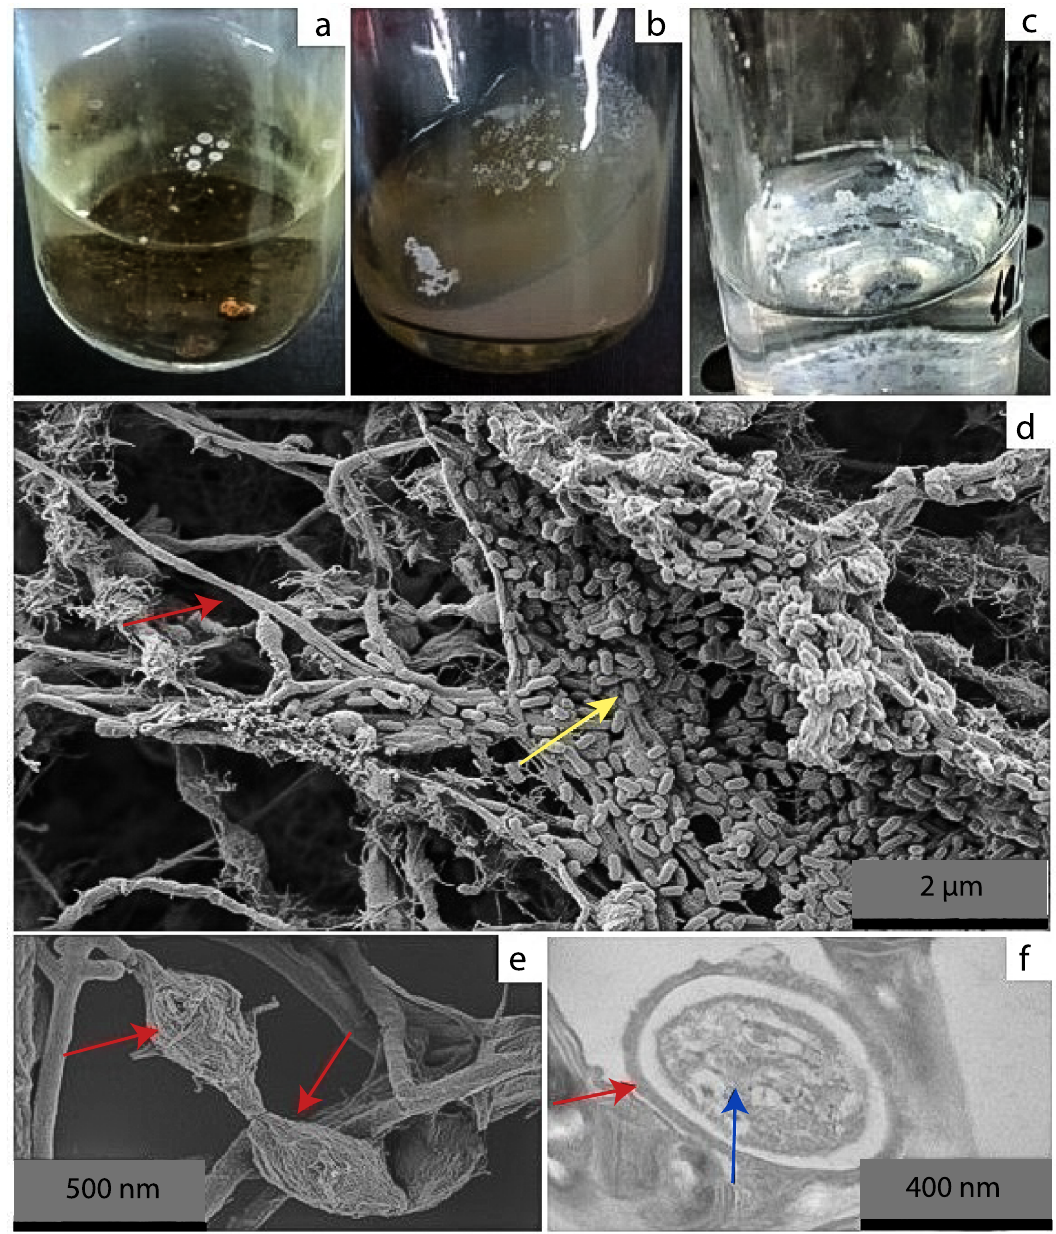
Fig. 1 Morphological overview of the chemolithoautotrophic consortium (carbonitro fl ex). Initial growth from soil samples. a Colonies growing in mineral medium supplemented with NH 4 Cl; b growth on N-FIX medium supplemented with clinoptilolite; c growth on N-FIX medium fi lled with synthetic air, CO, and CO 2 ; d confocal electron photomicrograph of carbonitro fl ex grown in N-FIX medium without nitrogen- fi xation sources (magni fi cation 11,210×) showing non- fi lamentous bacteria (yellow arrow) deposited on actinobacterial fi lamentous growth (red arrow); e scanning electron photomicrograph depicting the details of the spore-like structure (red arrows) (magni fi cation 51,000×); and f transmission electron photomicrograph (magni fi cation 71,000×) showing the vacuoles (blue arrows), well-delimited membrane, and cell wall (red